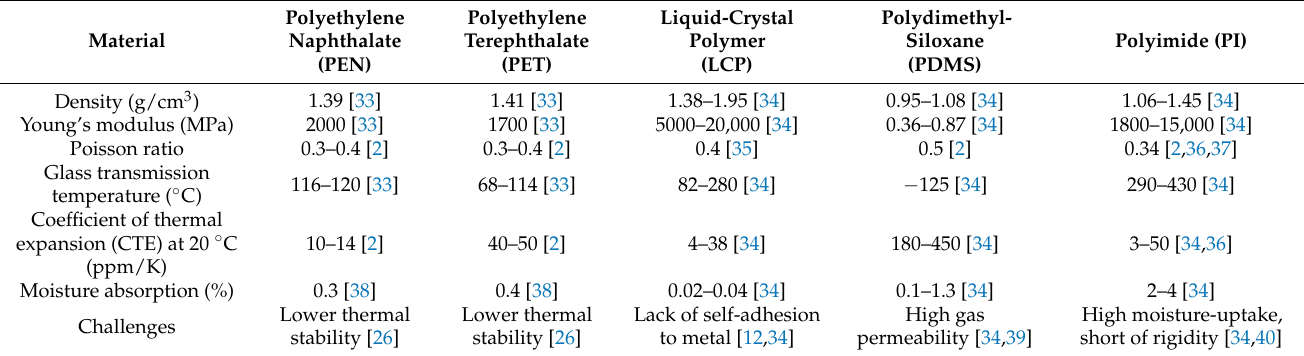
Table 1. Overview of the most used plastic substrates for flexible electronics and some of their properties.